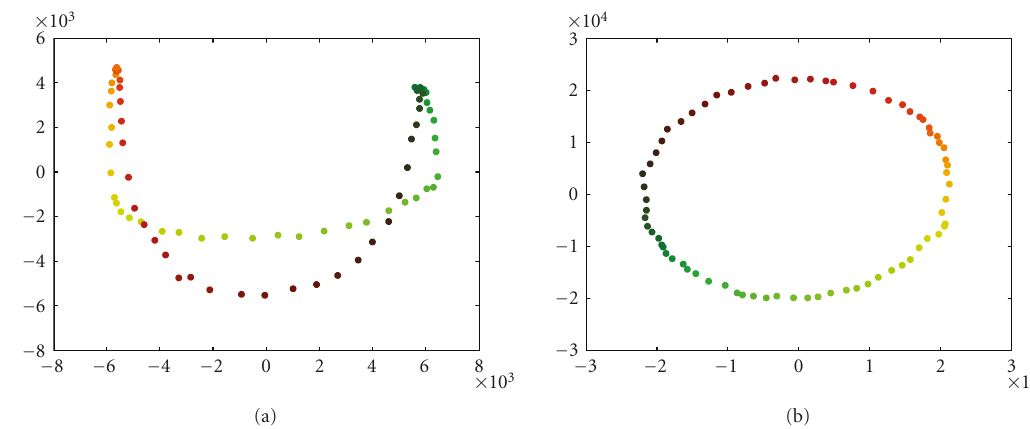
Figure 4: Reduced space computed by (a) PCA and (b) S P for the duck of the COIL-20 database.